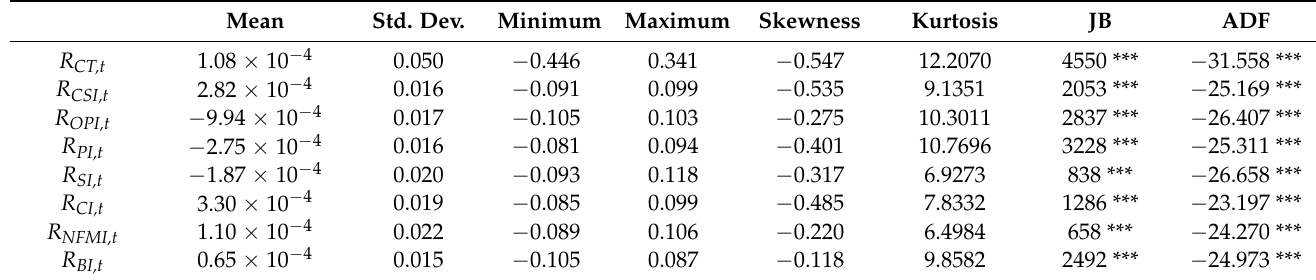
Table 1. Descriptive statistics and unit root tests of the logarithmic return of each market.